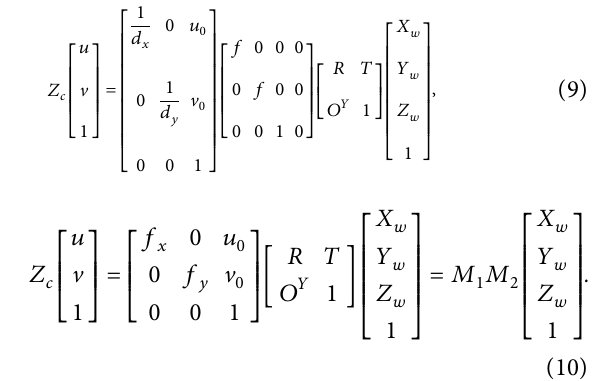
Figure 4: Pinhole imaging